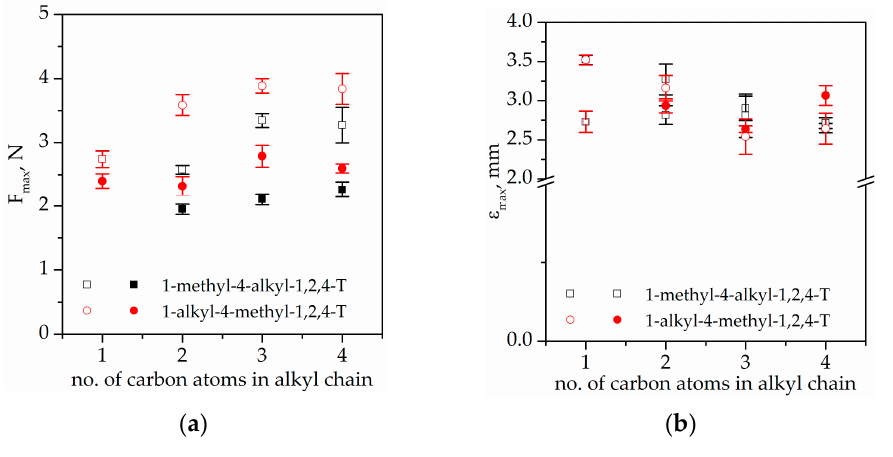
Figure 10. ( a ) Puncture resistance; ( b ) distance at puncture of ionogels. Filled symbols— PETMP+TATT system; open symbols—PETMB+TATT system.